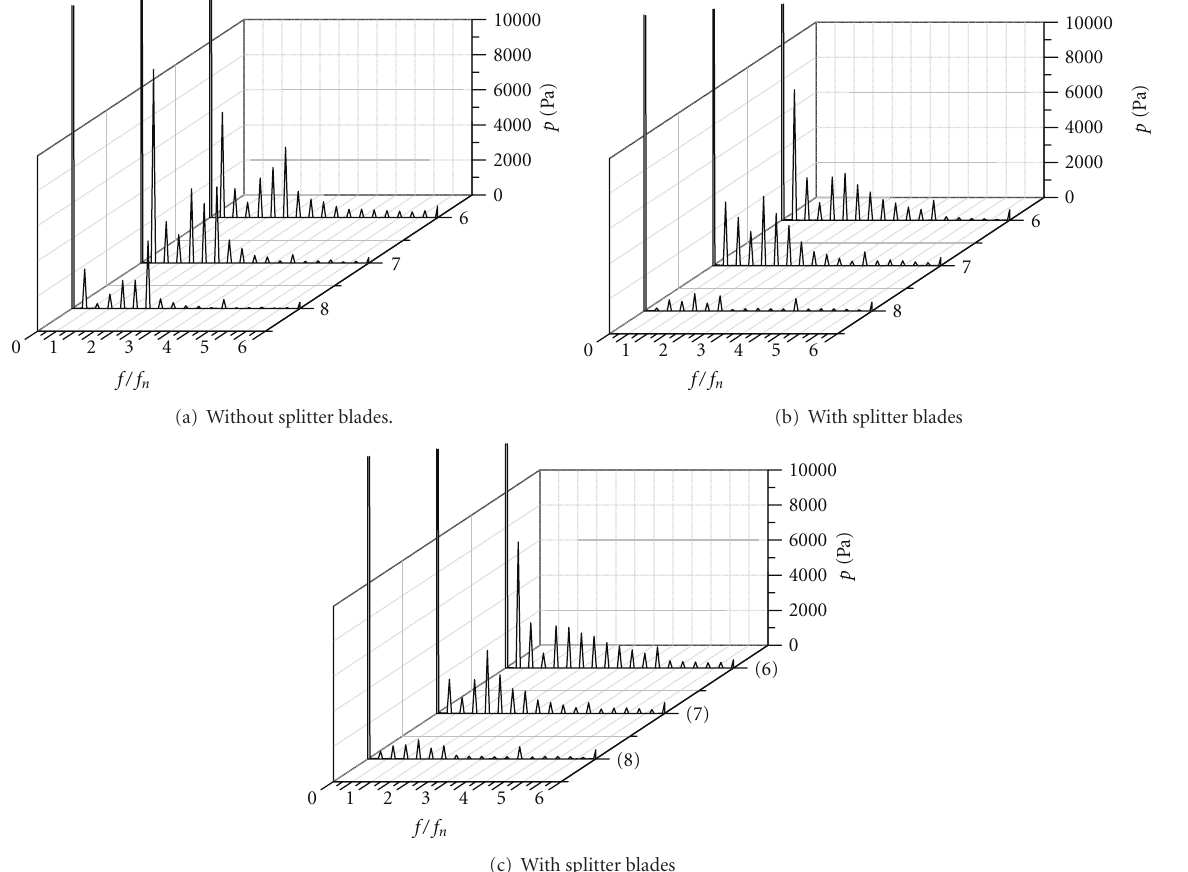
Figure 9: Frequency domain of pressure pulsation at impeller monitoring